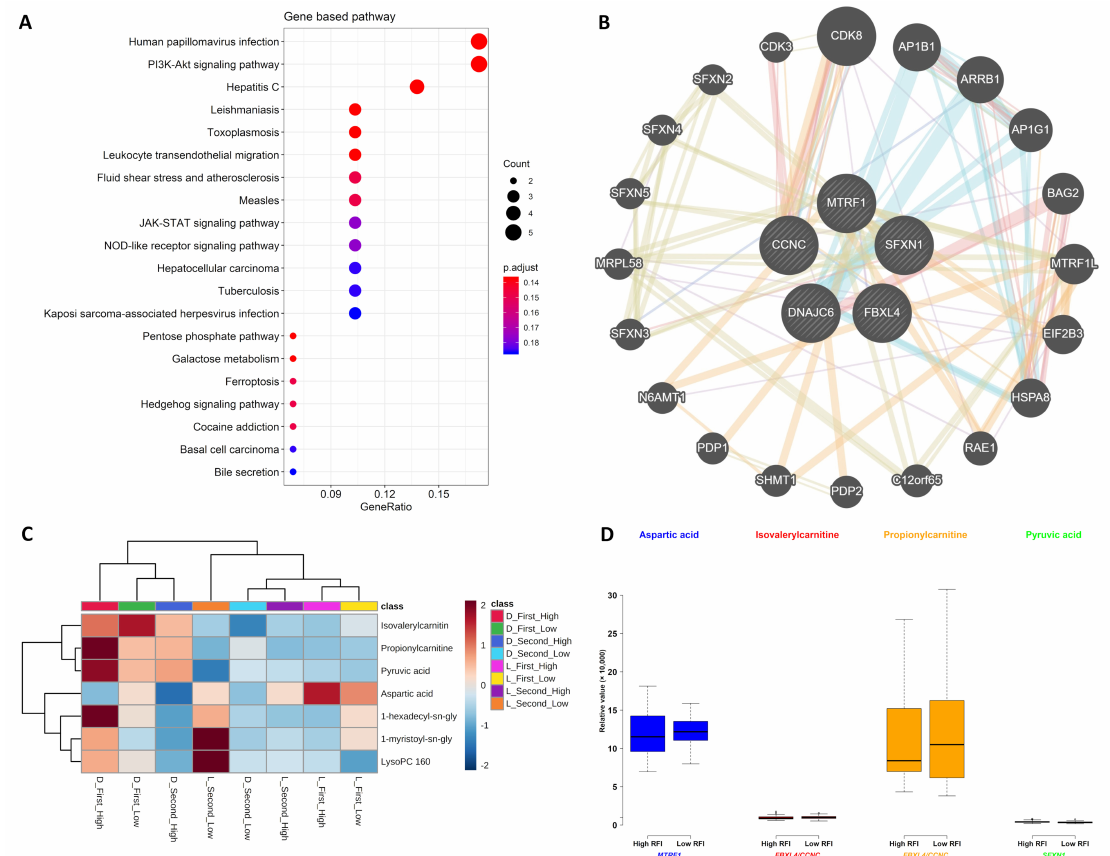
Figure 4. Gene pathway, metabolite cluster, and the interaction network: ( A ) Pathway for significant SNP-related genes. ( B ) Network for the genes in which significant SNPs were annotated to gene components. ( C ) Heatmap cluster for the metabolites that were associated with significant SNPs annotated to gene components. ( D ) Metabolites (i.e., aspartic acid, isovalerylcarnitine, propionylcarnitine, and pyruvic acid) values in high and low residual feed intake (RFI) pigs associated with the genes in which significant SNPs annotate to gene components. Note: The high RFI pigs and low RFI pigs were from left and right parts of all the pigs (n = 108) with one SD of actual RFI